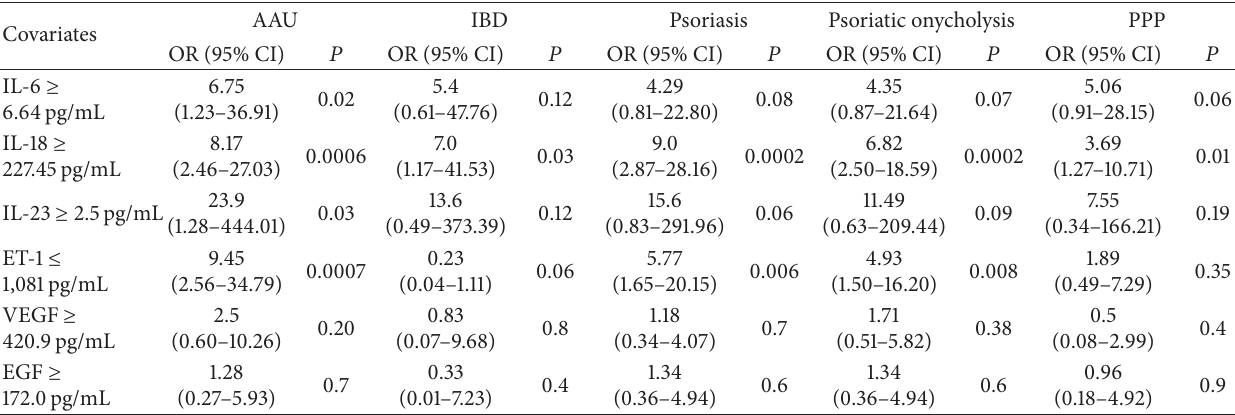
Table 5: A logistic regression model of the OR of serum levels of selected cytokines in spondyloarthritis groups of patients with different extra-articular symptoms compared to